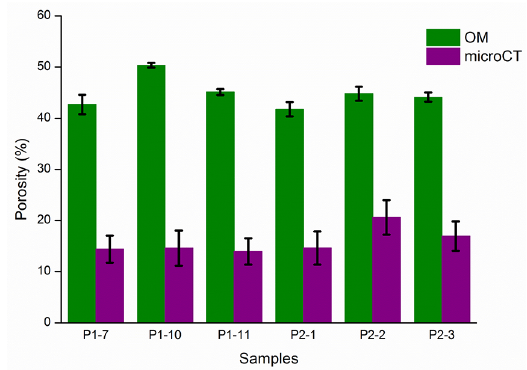
Figure 16. Comparison of porosity: microCT x